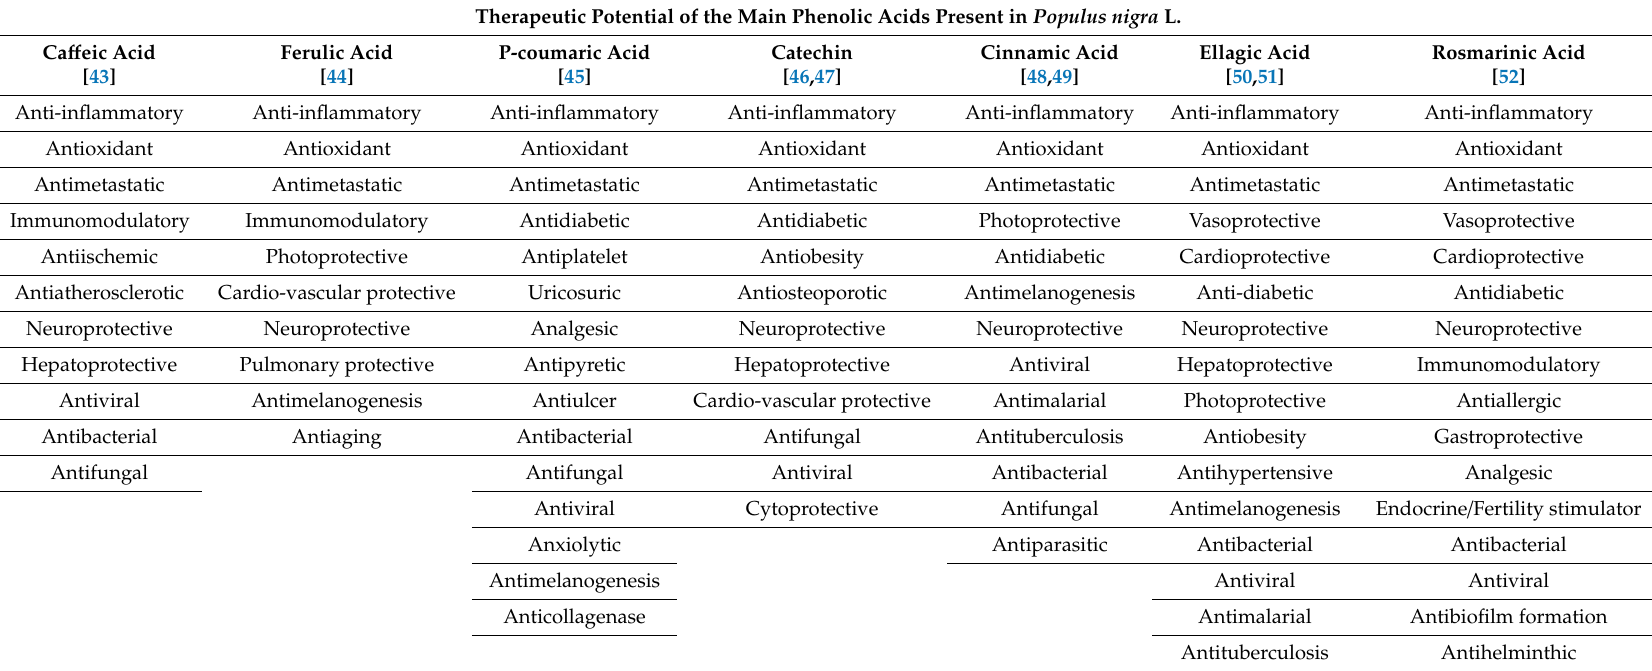
Table 2. Therapeutic potential of the main phenolic acids in Populus nigra L. Therapeutic Potential of the Main Phenolic Acids Present in Populus nigra